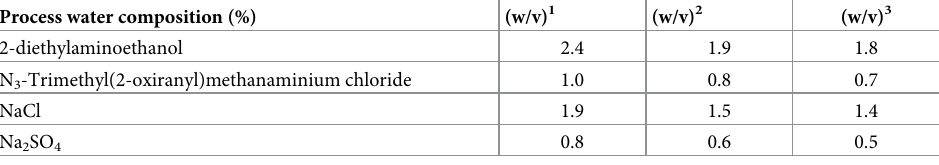
Table 1. Composition of simulated process water and estimated concentrations in a large-scale process water. Process water composition